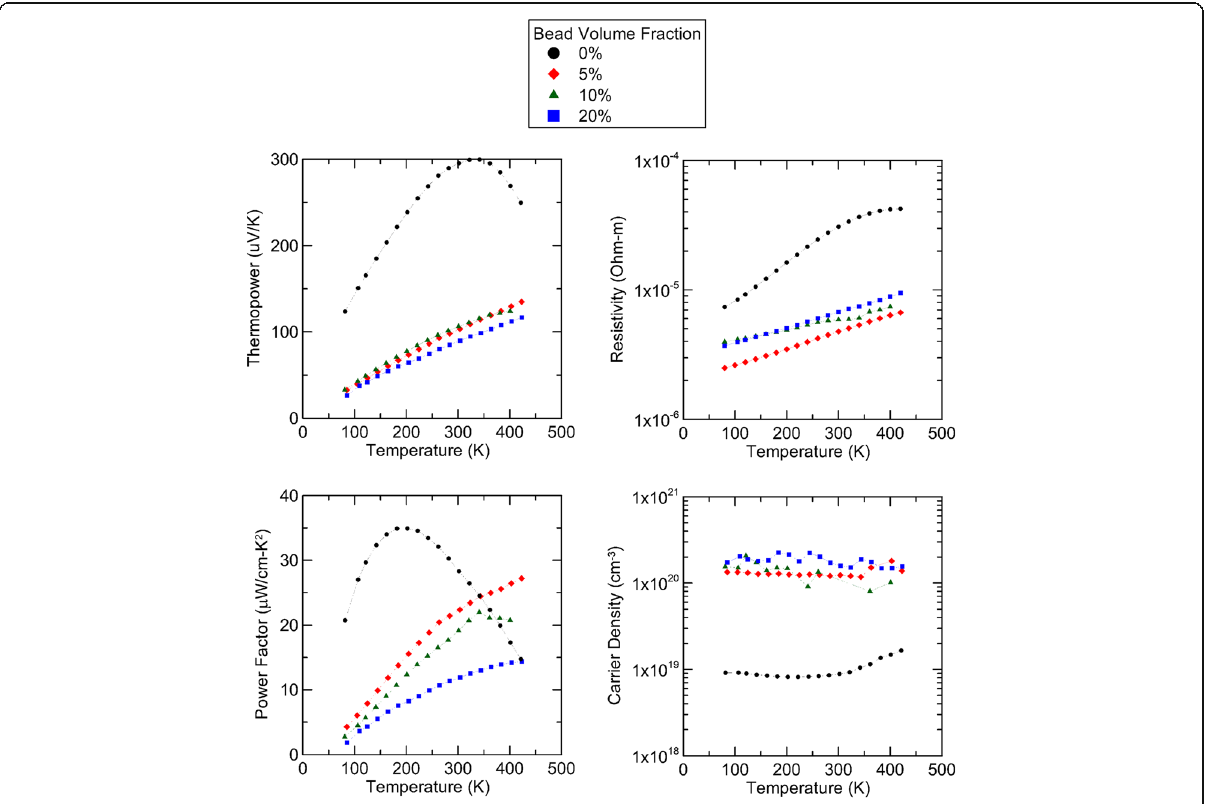
Fig. 4 Transport properties of a composite made of Ag-coated glass beads in a (Bi 0.25 Sb 0.75 ) 2 Te 3 host matrix. The thermopower, resistivity, power factor ( α 2 σ ), and Hall carrier concentration are shown as functions of temperature for the various volumetric filling fractions indicated. The presence of Ag-coated beads results in a strong increase in carrier concentration due to diffusion of Ag in the bulk of the